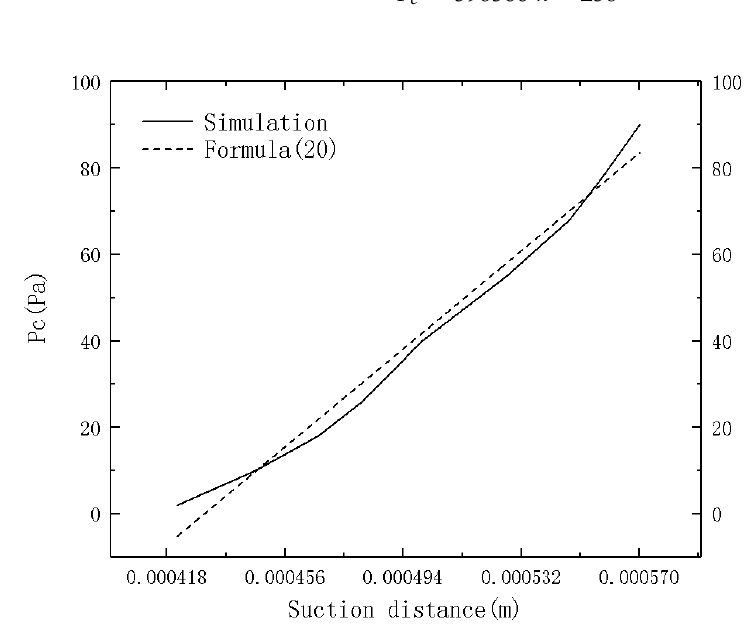
Figure 7. P c value curves corresponding to different suction distance.